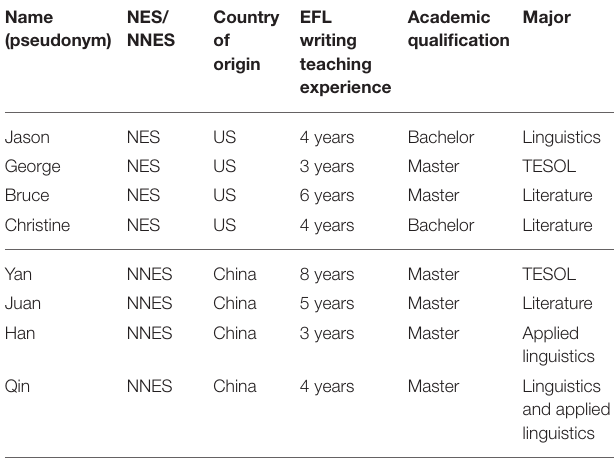
TABLE 1 | Participating teachers’